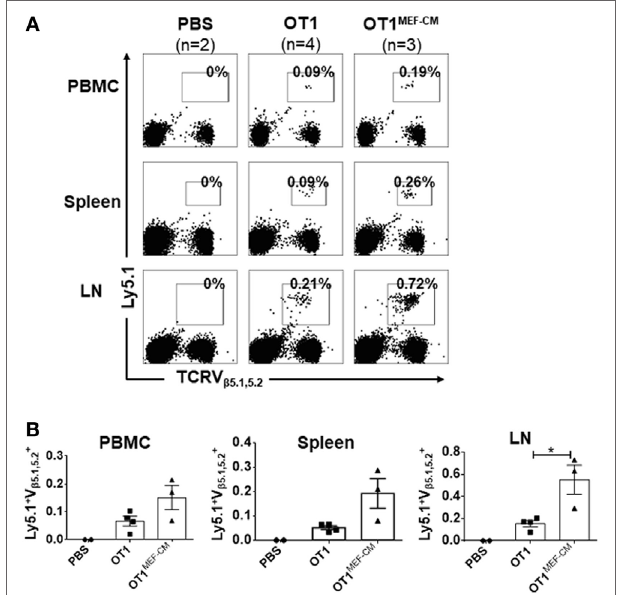
FigUre 5 | High potential of mouse embryonic fibroblast-conditioned medium (MEF-CM) cultured cytotoxic T lymphocytes in long-term persistence and proliferation after adoptive transfer. (a,B) Ly5.1 + / − OT-1 cells (5 × 10 4 ) that were generated in the presence or absence of MEF-CM (50%, v/v) were transferred to Ly5.2 + / + B6 wild-type mice. After 1 month, mice were subcutaneously administrated with OVA 257–264 peptide antigen and the number of Ly5.1 + / − OT-1 cells were determined from blood, spleen, and lymph node 5 days later. (a) A representative fluorescence-activated cell sorting result. (B) Summary of result (a) with recipient groups transferred with PBS alone (two mice), OT-1 cells (four mice), and OT-1 cells cultured with MEF-CM (three mice). Data are representative of two independent replicates. Statistical significance was analyzed by two-way ANOVA with Bonferroni’s multiple comparison test (* P ≤